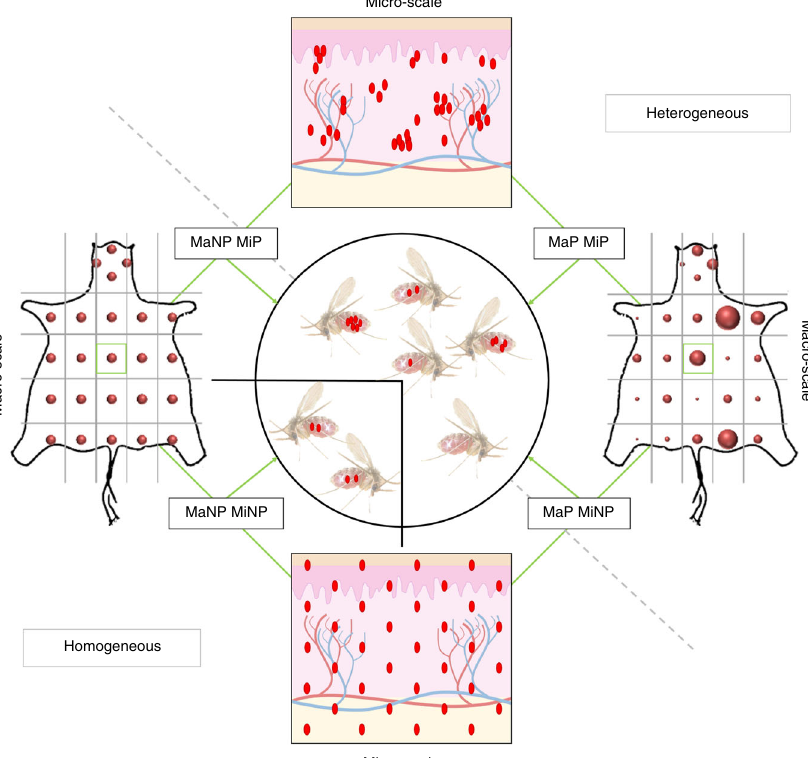
Fig. 4 Schematic representation of transmission model. Parasite distributions are assumed to be either homogeneous (not patchy = NP) or heterogeneous (patchy = P) in the skin. The macro-scale (Ma) considers heterogeneity at the scale of a skin biopsy, based on stereomicroscopic analysis of the whole skin and qPCR of punch biopsies. Each biopsy in turn has a micro-scale (Mi) parasite distribution, which may be either homogeneous or heterogeneous. A macro- and micro-homogeneous distribution (MaNP MiNP) results in all sand fl ies ingesting similar amounts of parasites, patchiness at either scale (MaP MiNP and MaNP MiP) results in heterogeneity in parasite uptake between sand fl ies, and patchiness at both scales (MaP MiP; as observed in the data) maximizes the heterogeneity in parasite